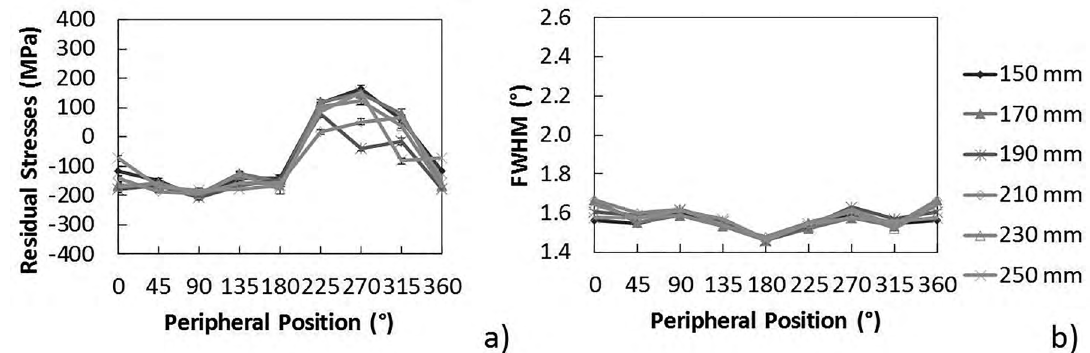
Figure 9. Residual Stresses in 50 µm depth of the raw material (a) and FWHM (b).